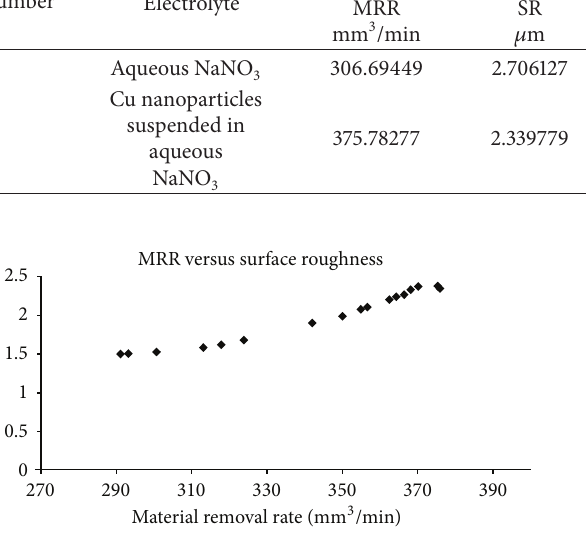
Figure 3: Optimal parameters of Cu nanoparticles suspended in aqueous NaNO 3 solution from multiobjective